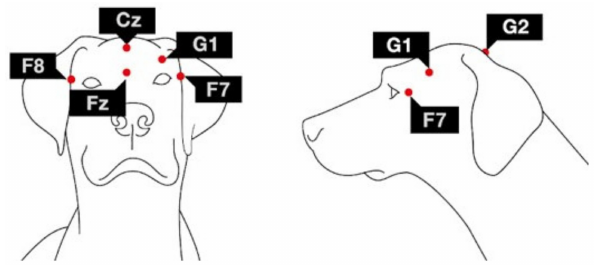
Figure 1. Placement of the electrodes. Fz and Cz: frontal and central midline; F7 and F8: left and right electrodes placed on the zygomatic arch; G2: reference electrode; G1: ground